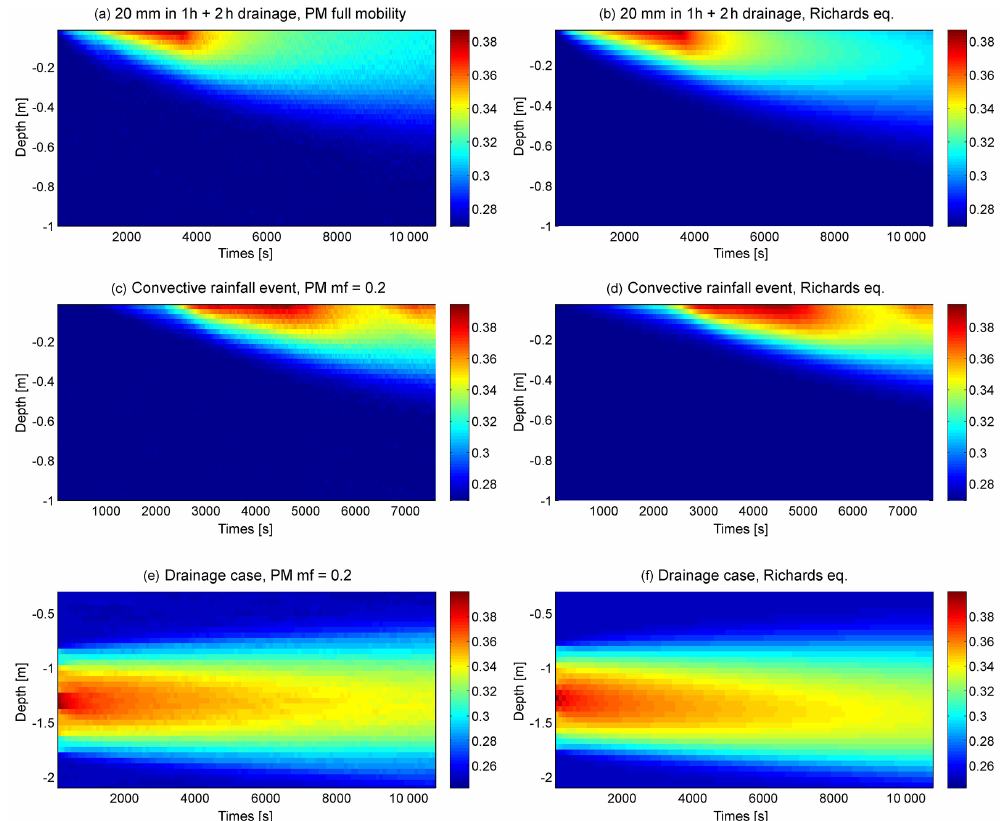
Figure 4. Time series of soil moisture simulated with the particle model (PM) and the Richards solver for the sandy soil as 2-D colour plots for a simulated wetting event of 20mm in 1h and an additional 2h of drainage ( a and b ), the convective rainfall event ( c and d ) and the drainage experiment ( e and f